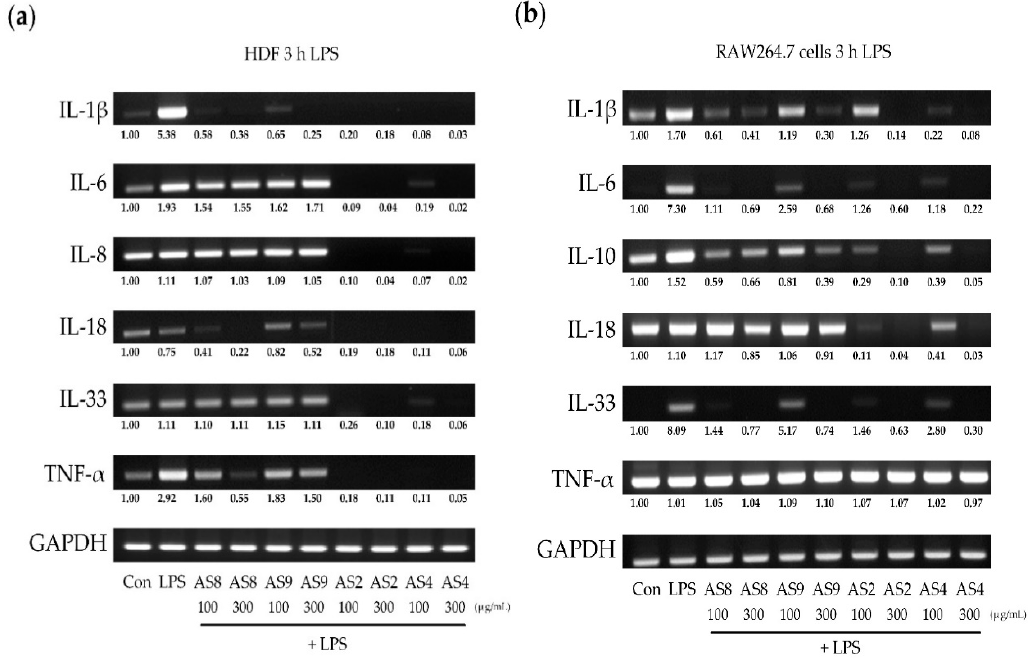
Figure 4. Changes in cytokine expression induced by LPS in ( a ) human dermal fibroblasts (HDFs) and ( b ) RAW264.7 mouse macrophages treated with AS extracts.